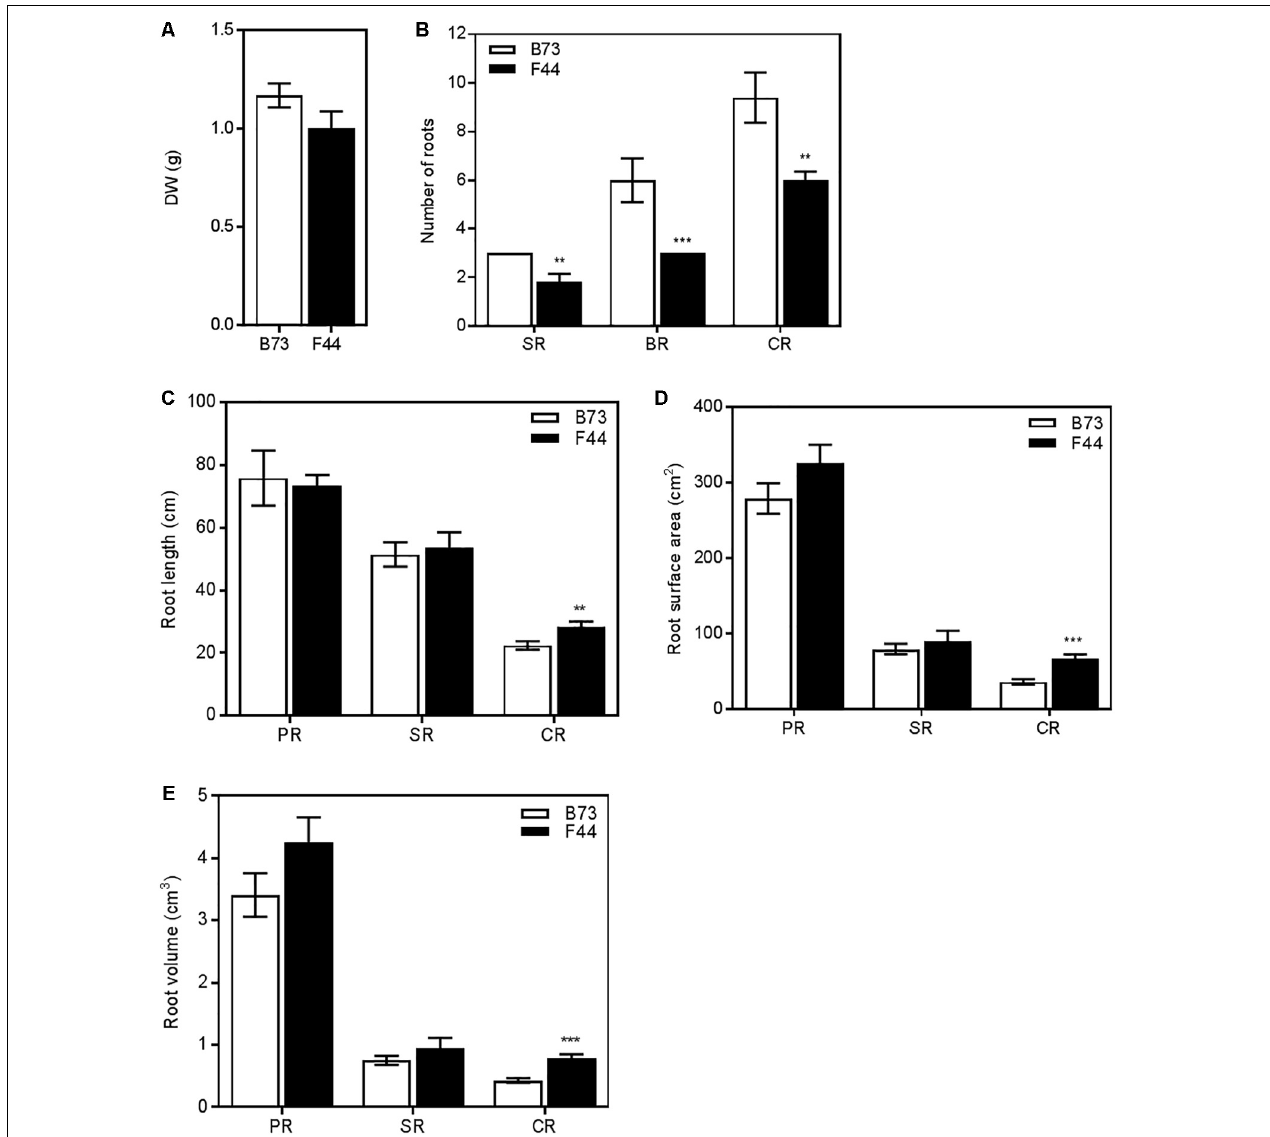
FIGURE 4 | Root architecture measurements of B73 (white) and F44 (black) plants grown on sand. (A) Total root system dry weights. (B) Number of seminal roots (SR), brace roots (BR) and crown roots (CR). (C) Individual root lengths. (D) Individual root surface areas. (E) Individual root volumes. Values are means ( ± SE) from five individual plants. Similar results were obtained in another independent experiment. Asterisks indicate significant differences between lines at ∗∗ P < 0.01, ∗∗∗ P < 0.005 (Student’s t -test).